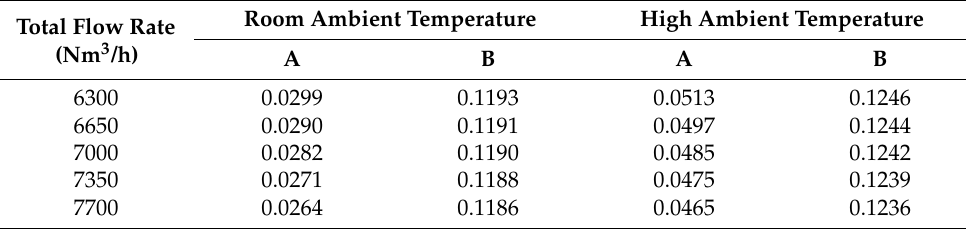
Table 3. The slopes of the A and B segments.